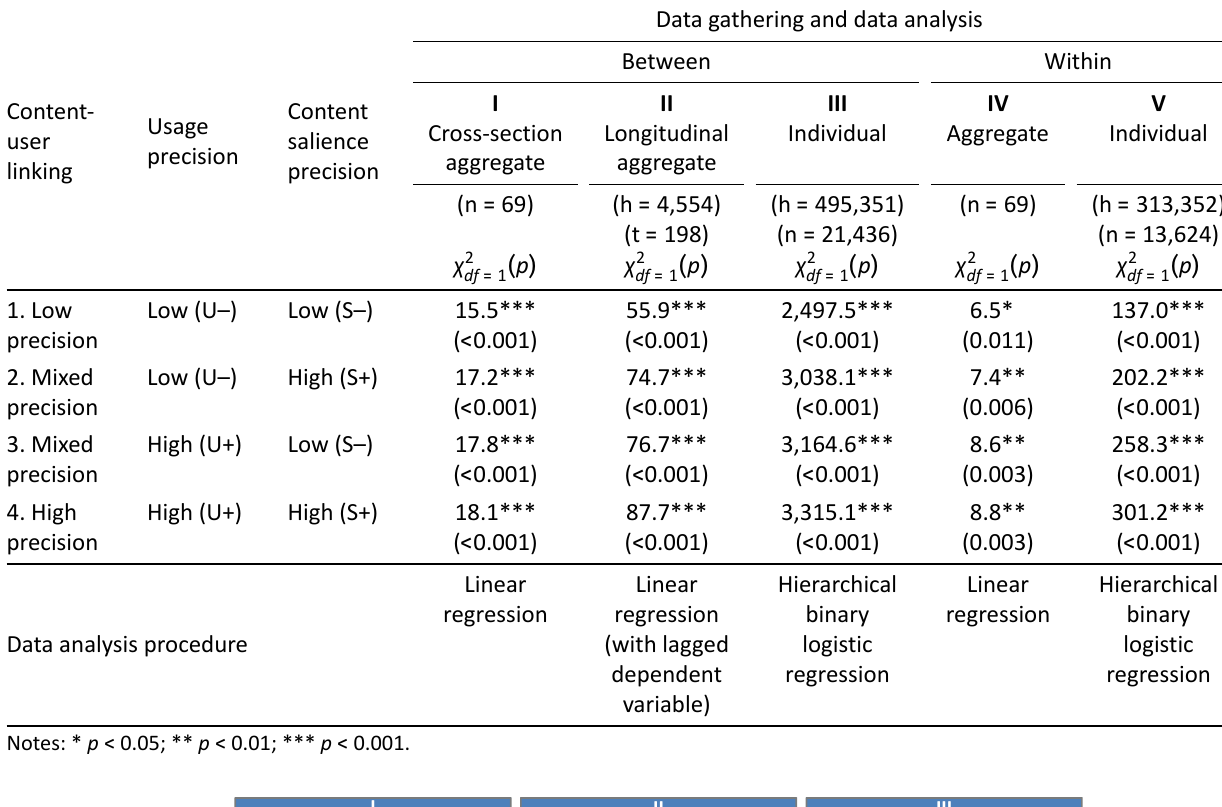
Table 2. Statistical significance level of including issue exposure in the prediction of issue salience: Likelihood ratio tests.